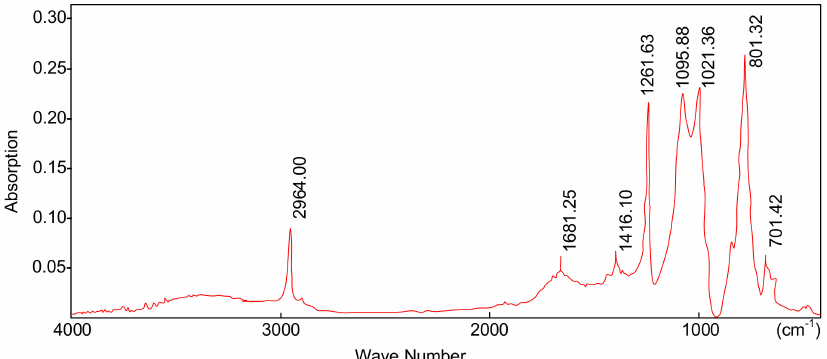
Figure 5. Infrared spectral analysis of solid substance.